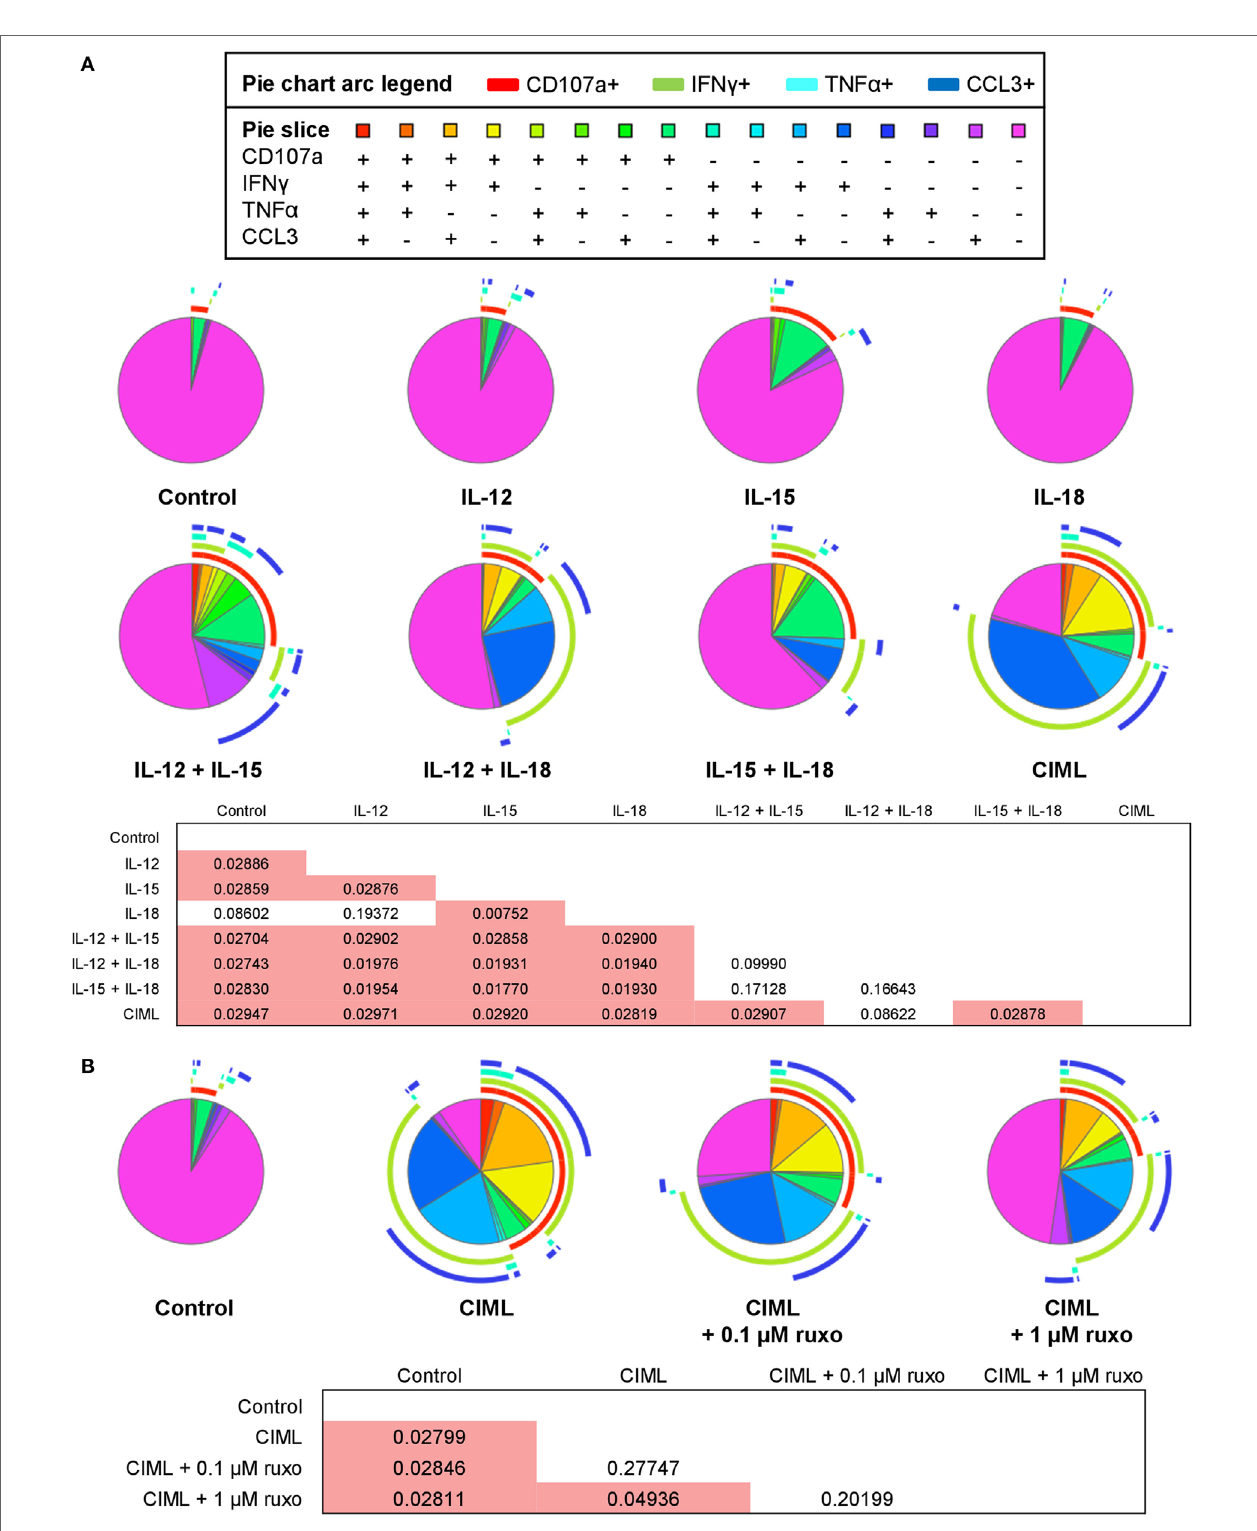
FigUre 3 | Polyfunctionality of cytokine preactivated natural killer (NK) cells after the preactivation phase. (a) Pie charts representing the percentages of control non-preactivated and cytokine preactivated NK cells expressing CD107a, interferon (IFN) γ , tumor necrosis factor (TNF) α , and/or C-C motif chemokine ligand (CCL)3 ( n = 4). (B) Pie charts representing the percentages of control non-preactivated and cytokine-induced memory-like (CIML) NK cells, and CIML NK cells preactivated in the presence of 0.1 and 1 µM ruxolitinib, expressing CD107a, IFN γ , TNF α , and/or CCL3 ( n = 4). Differences between pie charts were established with non- parametric permutation test. The p -values are in the boxes below the pie charts. Significant differences are in the red cells.